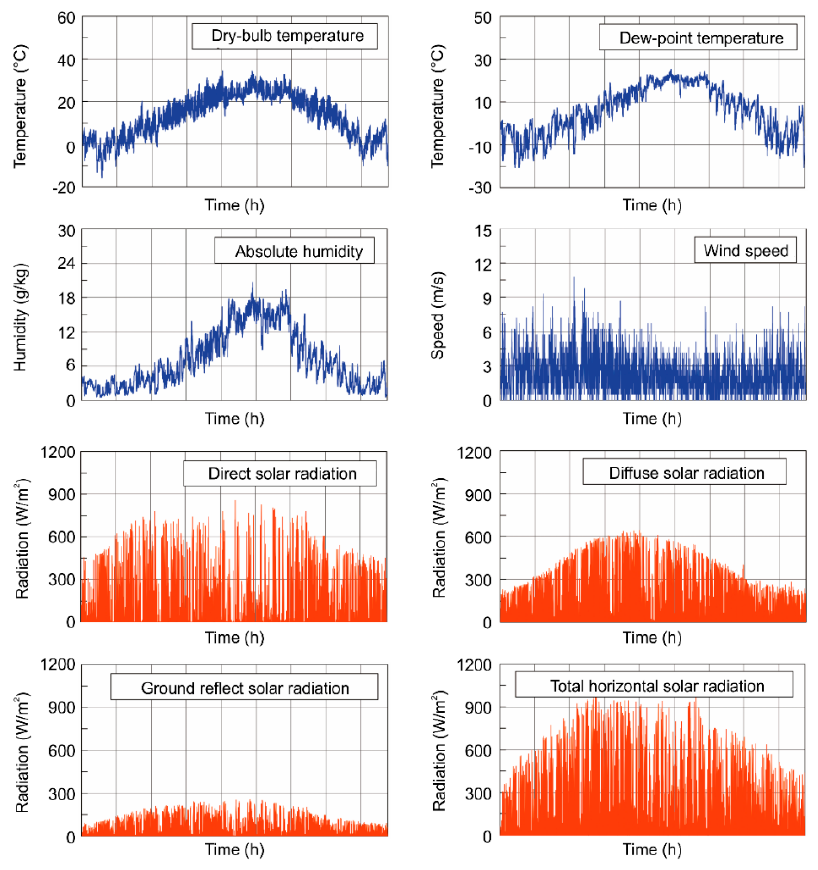
Figure 6. Annual Seoul standard weather data.